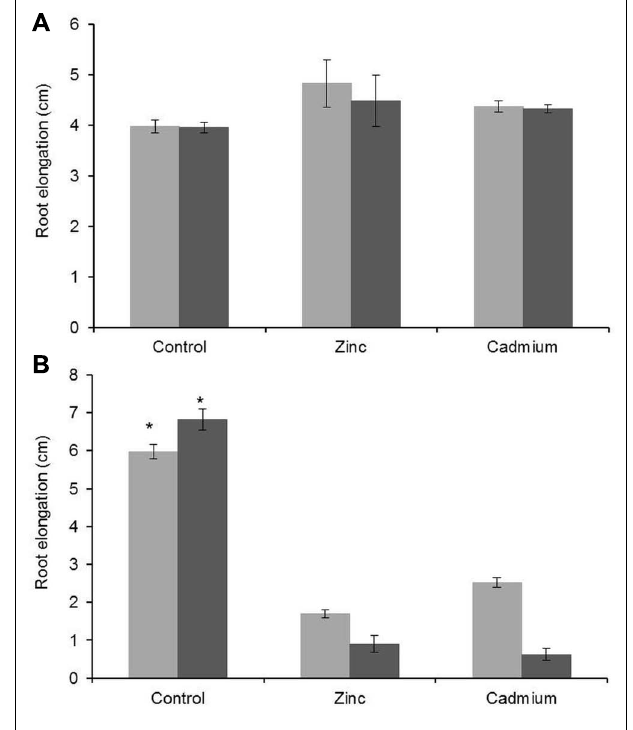
FIGURE 4 | Increase in root length of G. claussenii plants after 3 days (light gray bars) and 6 days (dark gray bars) of exposure to 2 μ M zinc (Zn; control), 3000 μ M Zn (zinc), and 100 μ M Cd (cadmium) (A); and of G. elegans plants after exposure to 2 μ M Zn (control), 100 μ M Zn (zinc), and 5 μ M Cd (cadmium) (B). Mean values and standard errors are shown ( n = 6). Asterisks denote significant differences of control (2 μ M Zn) from treatments as found uponTukey’s testing ( P <